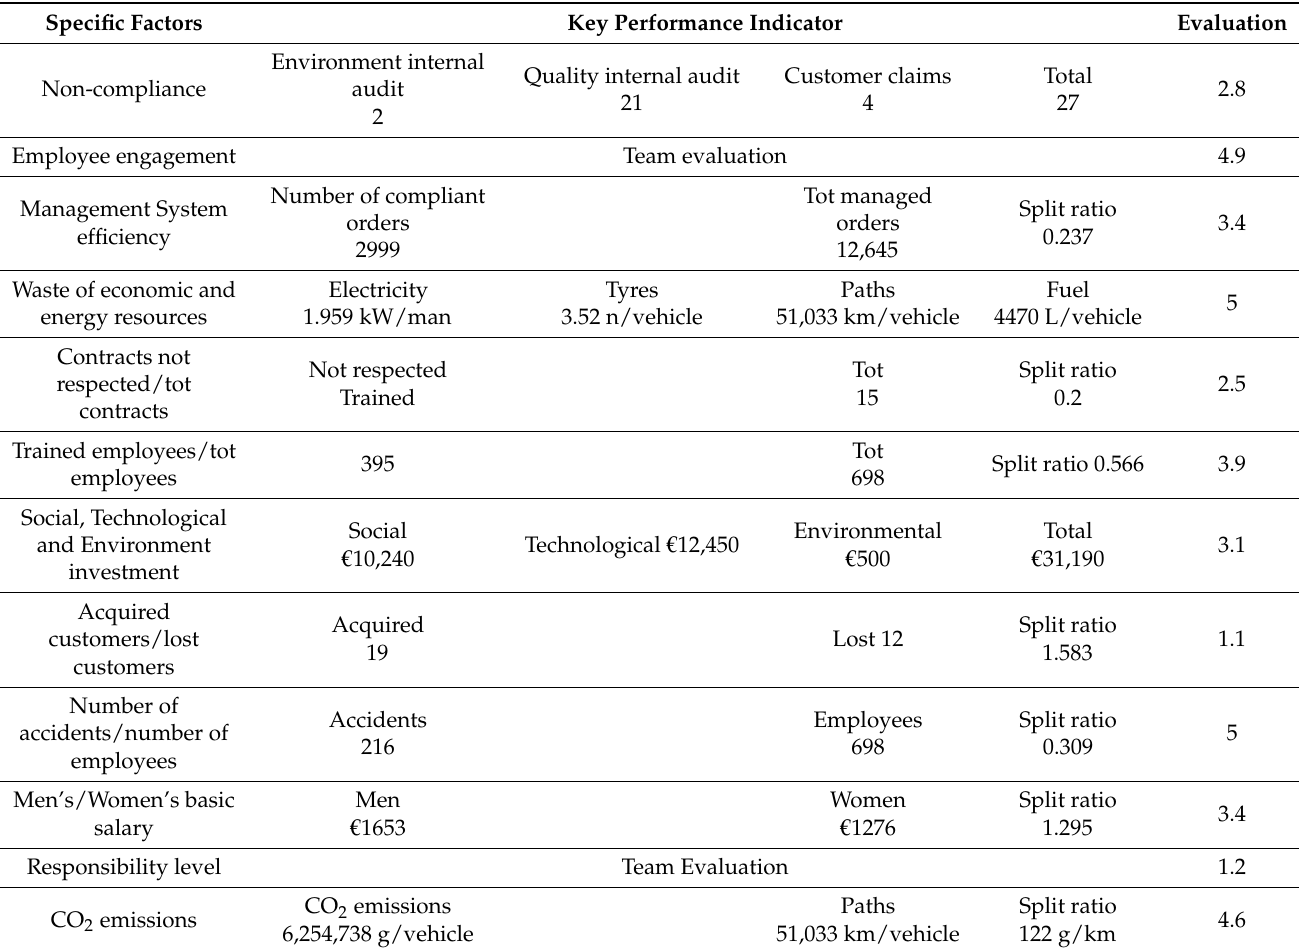
Table 4. Integrated Balance Sheet for